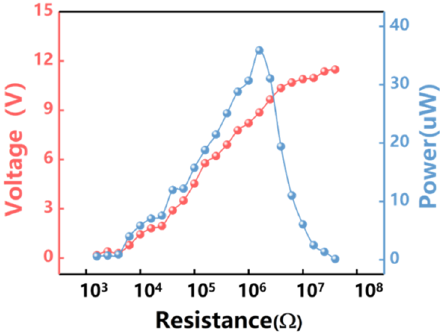
Figure A2. Microstructure of nylon and PTFE. ( a ) microstructure of PTFE ( b ) microstructure of Nylon.